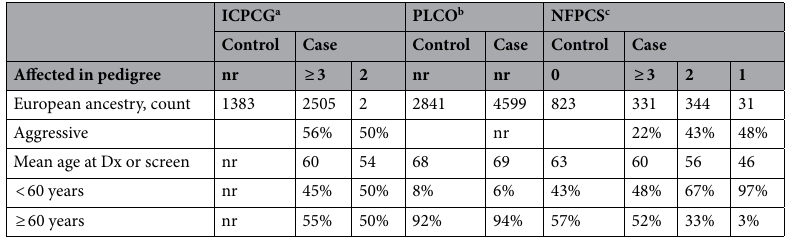
Table 1. Study populations. Dx, diagnosis; nr, not recorded. a Subjects of 12 aggregated studies of the International Consortium for Prostate Cancer Genetics (ICPCG, dbGaP phs000733.v1.p1). b Subjects of the Prostate, Lung, Colorectal, and Ovarian (PLCO) cancer screening trial’s Prostate Cancer Genome-Wide Association Study for Uncommon Susceptibility Loci (PEGASUS, dbGaP phs000882.v1.p1). c Subjects of the Nashville Familial Prostate Cancer Study (NFPCS). All subjects are genetically independent and of European ancestry. Aggressive is defined: ≥ pT3, or N1, or M1, or Gleason ≥ 8, or PSA ≥ 20 ng/ml, or lethal prostate